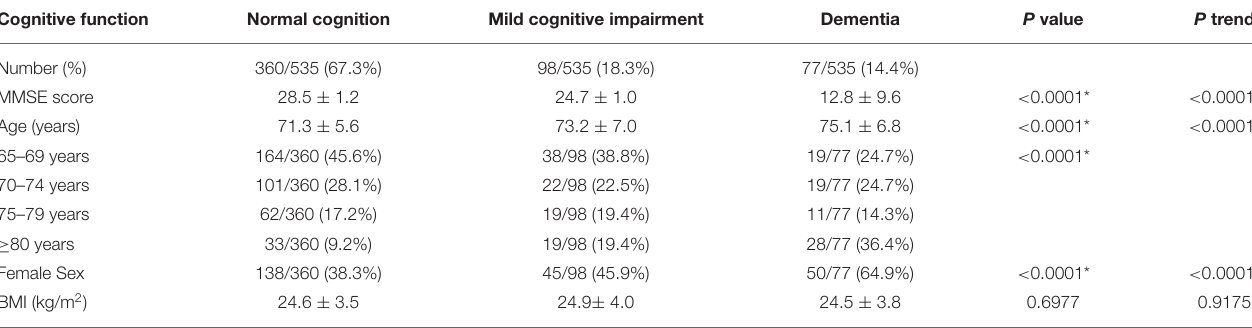
TABLE 1 | Demographic characteristics of the three cognitive groups ( N = 535). Cognitive function